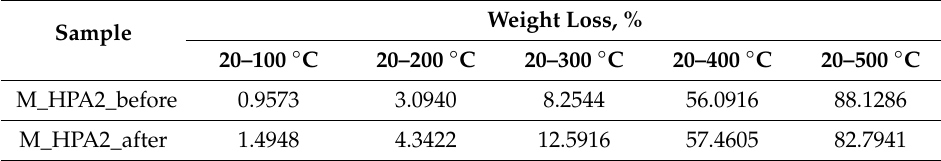
Table 5. Inflexion points of TG curves before and after biodegradation.